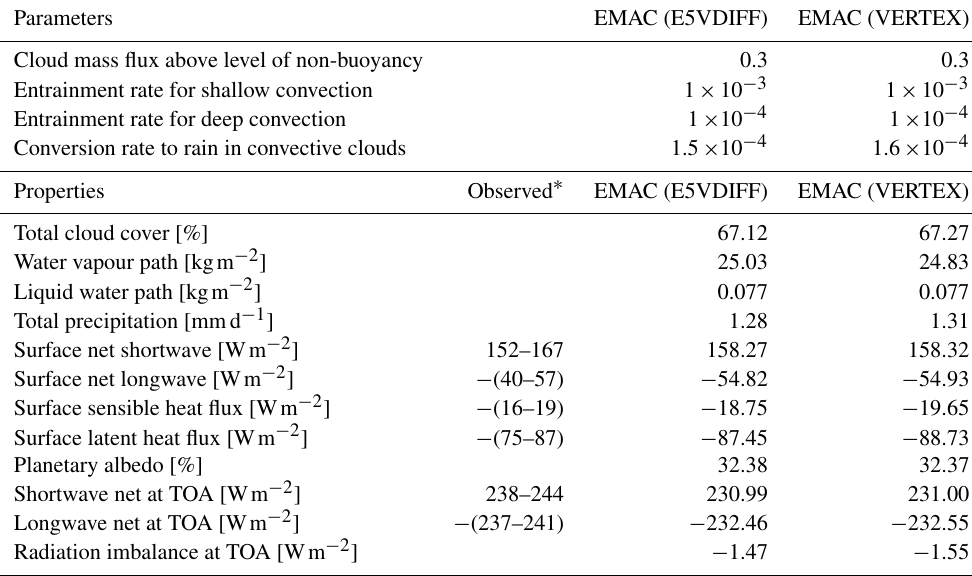
Table 2. Overview of tuning parameter settings and global mean properties.